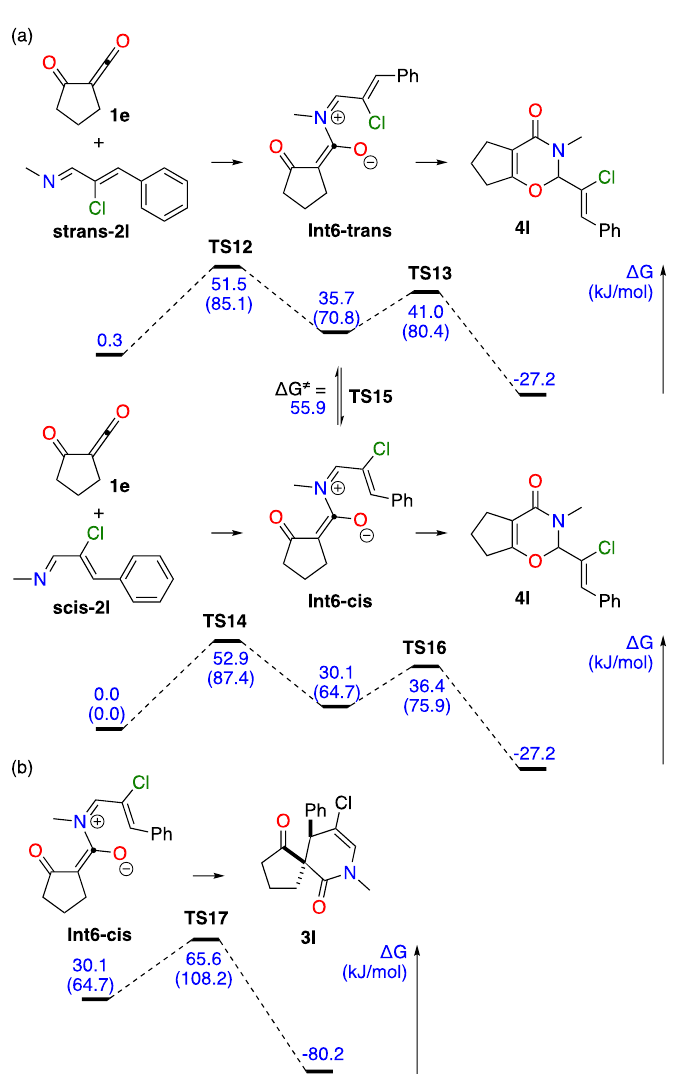
Figure 3. Free Gibbs energy profiles computed at 298 K (DFT, B3LYP-D3/6-311++G(d,p)) of the aza-Diels−Alder reactions between the α-oxoketene 1e and the 1-azadiene 2l . Free Gibbs energies noted between parentheses were computed at 473 K. For 1-azadiene 2l , the s-cis/s-trans denomination refers to the conformation of the 4π system of the 1-azadiene, not to the regular CIP nomenclature.